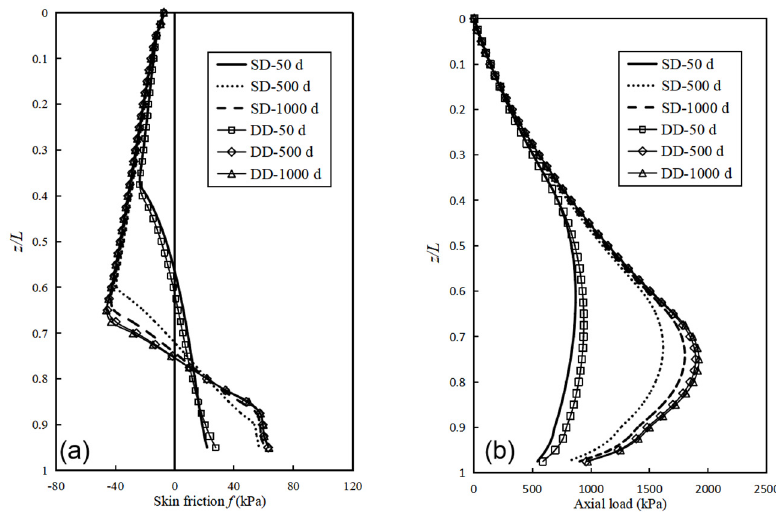
Figure 9. Effect of drainage condition on ( a ) skin friction and ( b ) axial load.